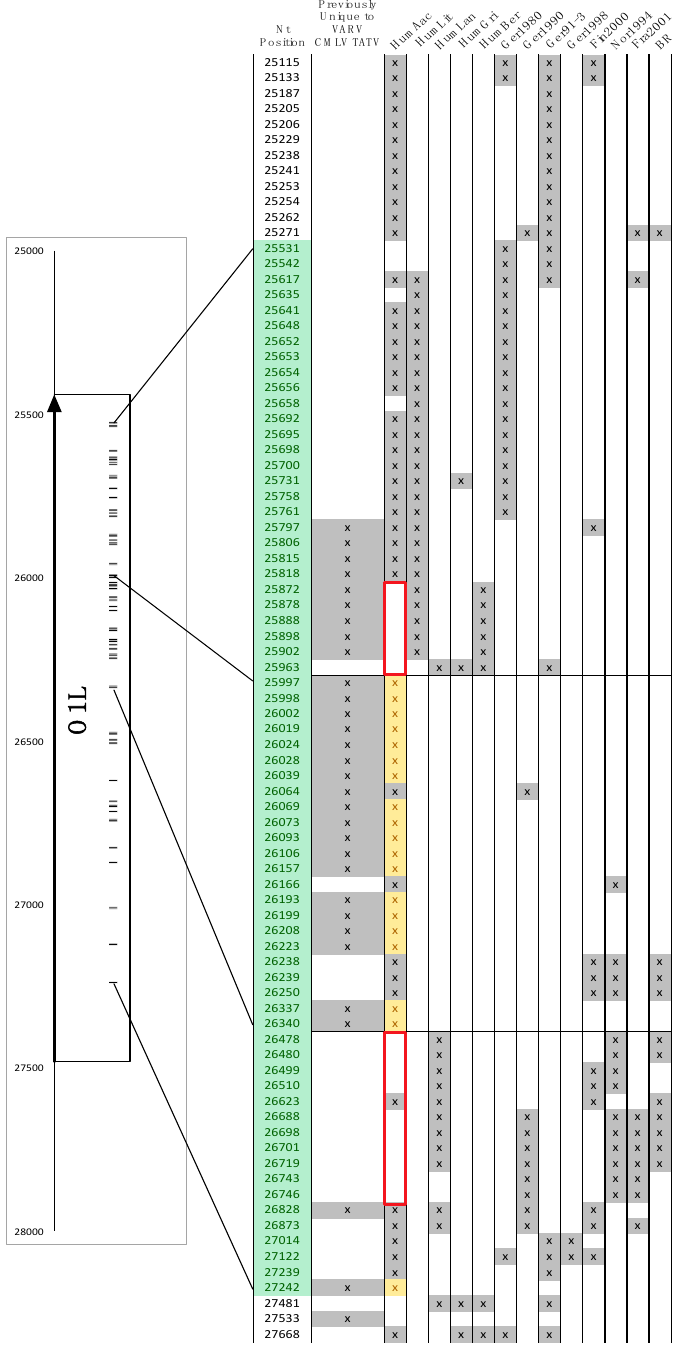
Figure 7. Organization of SNPs within the VARV O1L gene. Nucleotide positions refer to the gapped core alignment used previously. SNPs, shown by nucleotide position, were identified by the BBB search “find positions of nucleotides that are identical in VARV + CMLV + TATV, but different in all CPXVs and VACVs with a tolerance of 5” (i.e. up to five other genomes can match the VARV + CMLV + TATV nucleotide). SNPs in the “Previously Unique to VARV + CMLV + TATV” column are from previous work before the VARV-like CPXVs were sequenced. The positions that also match “tolerated CPXV genomes” are indicated by an “x” in columns labeled with CPXV strain. The arrow in left panel and SNPs shaded green indicate the extent of the O1L gene; yellow indicates SNPs that are unique to VARV + CMLV + TATV + VARV-like-CPXV sequences. Red boxes indicate regions where CPXV-HumAac09 does not match the VARV + CMLV + TATV nucleotide but where other CPXVs do.